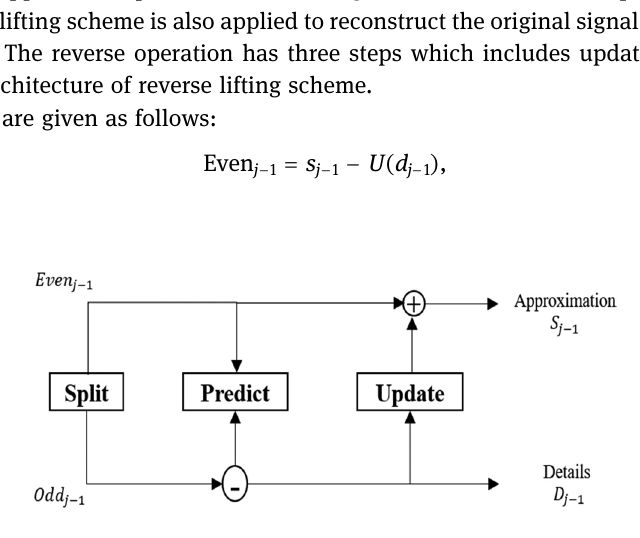
Figure 2: Forward lifting